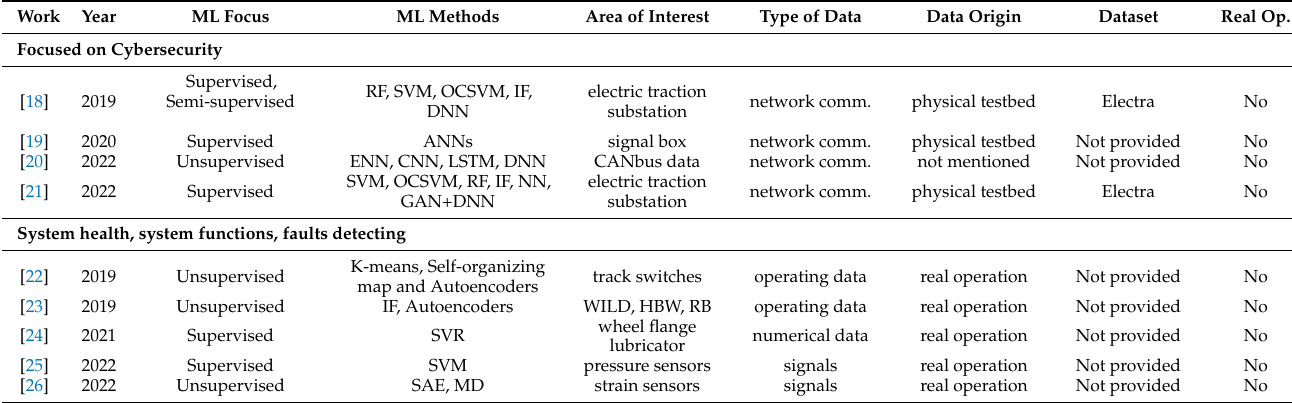
Table 1. Summary of the state-of-the-art in railway anomaly